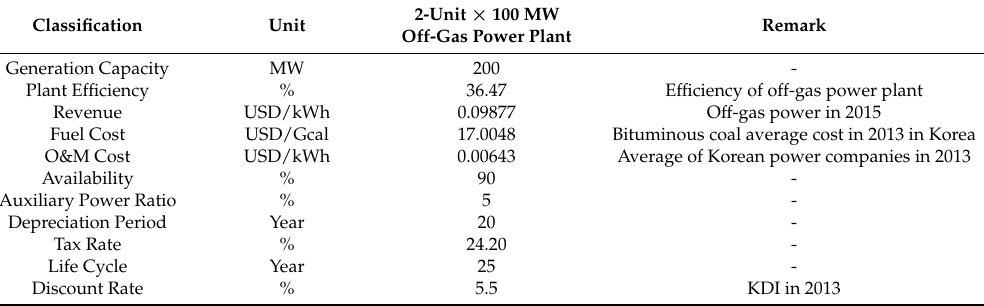
Table 5. Input parameters for the economic analysis of a 200 MW power plant fired by blast furnace gases.